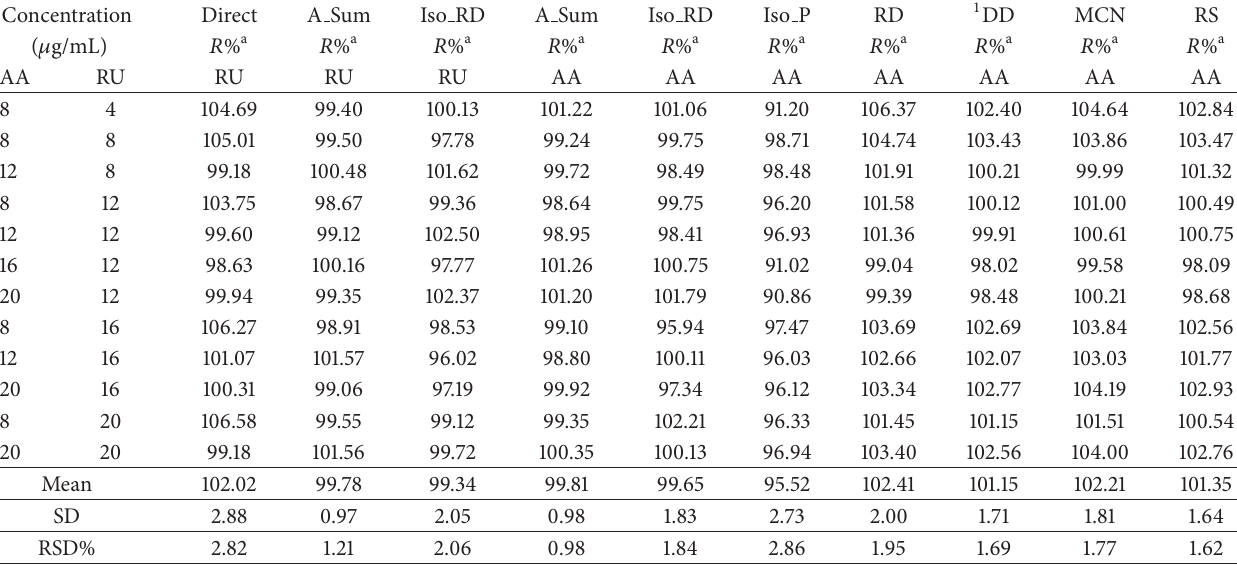
Table 1: Determination of AA and RU in laboratory prepared mixtures by the proposed spectrophotometric methods.